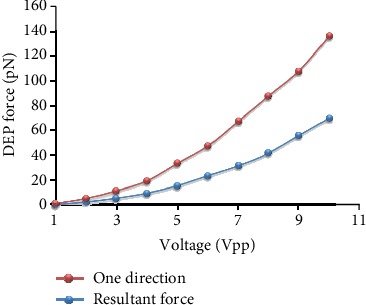
Relationship between the DEP force and voltage. The blue line represents the DEP force in one direction, and the red line represents the resultant force.